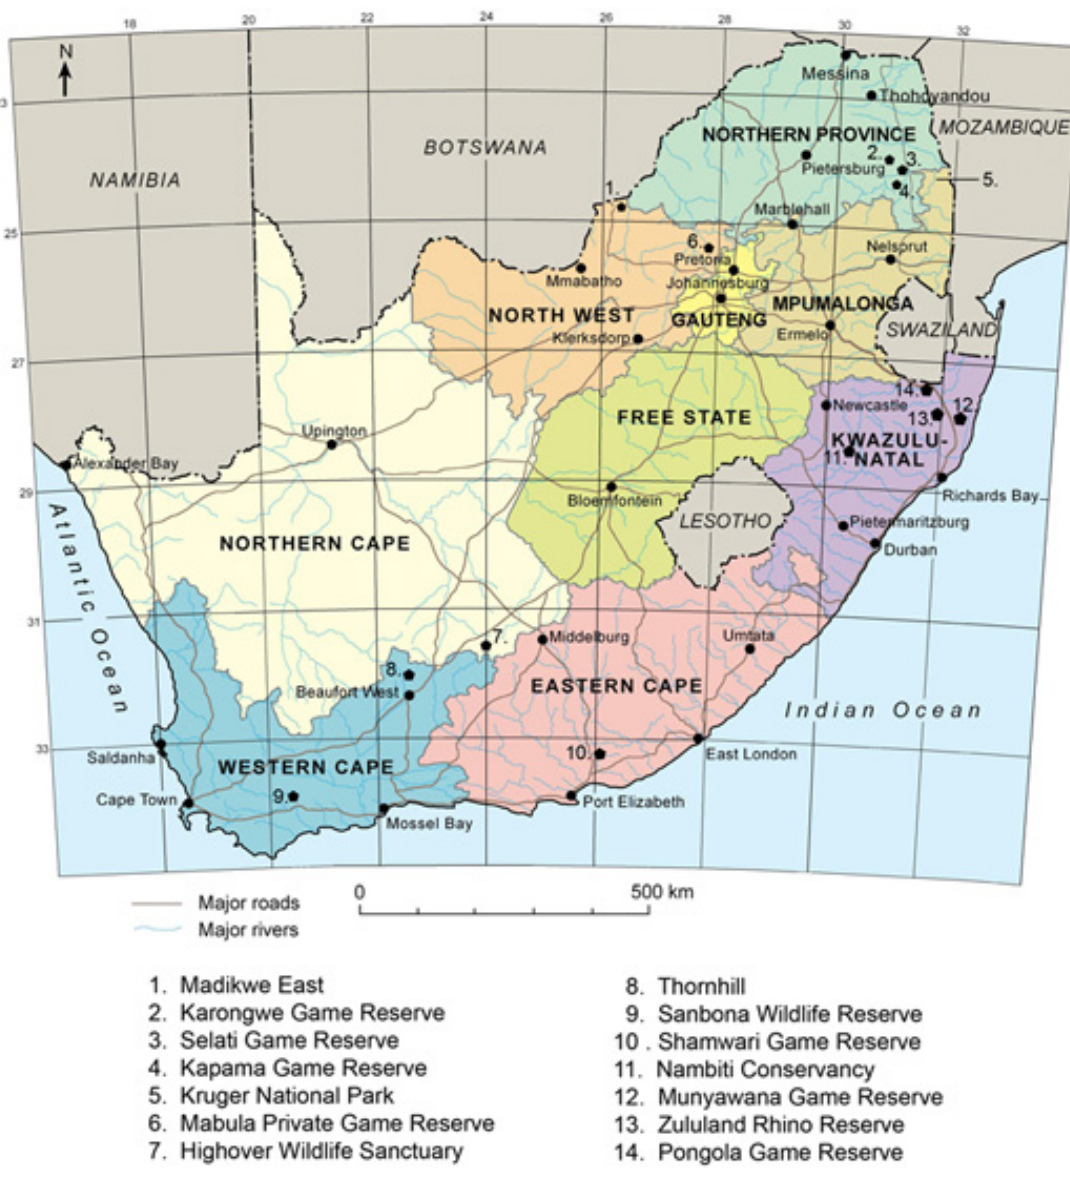
Fig. 1. Map showing distribution of provinces in South Africa (Source: Department of Environmental Affairs and Tourism) and locations referred to in this